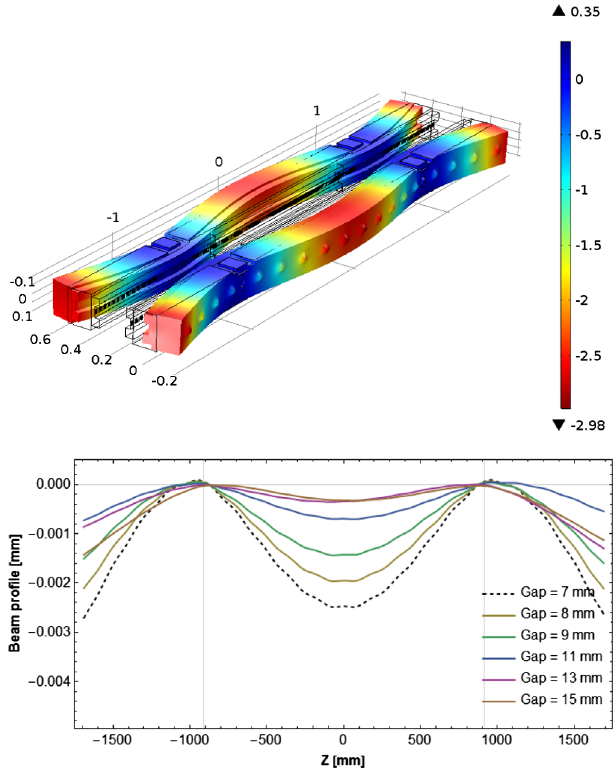
FIG. 6. Simulation results of the strongback deformation, calculated using COMSOL and using actual forces from the spring units. The deflection shown in the upper panel corresponds to a gap of 7.2 mm. Unlike the analytical result of Fig. 5, which included only the stiffness of the strongback, this simulation includes stiffness from the strongback and the sections of magnet/ pole holder. The deformation is therefore somewhat smaller at the same gap.